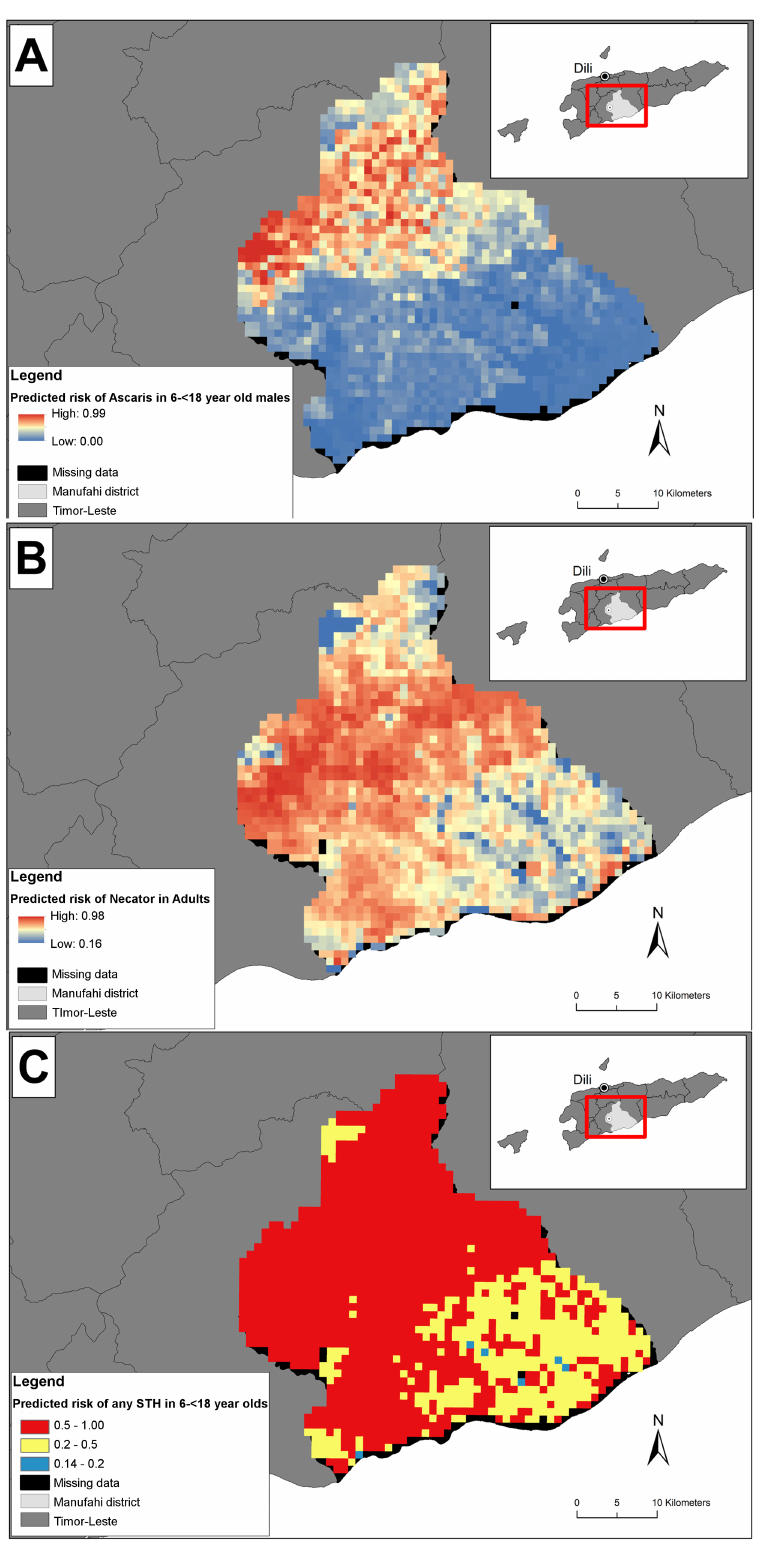
Fig 2. Predictive risk maps for A . lumbricoides , N . americanus and any STH infection in Manufahi. (A) Predicted risk of A . lumbricoides infectionin the highestrisk group, 6– < 18year old males, (B) Predicted risk